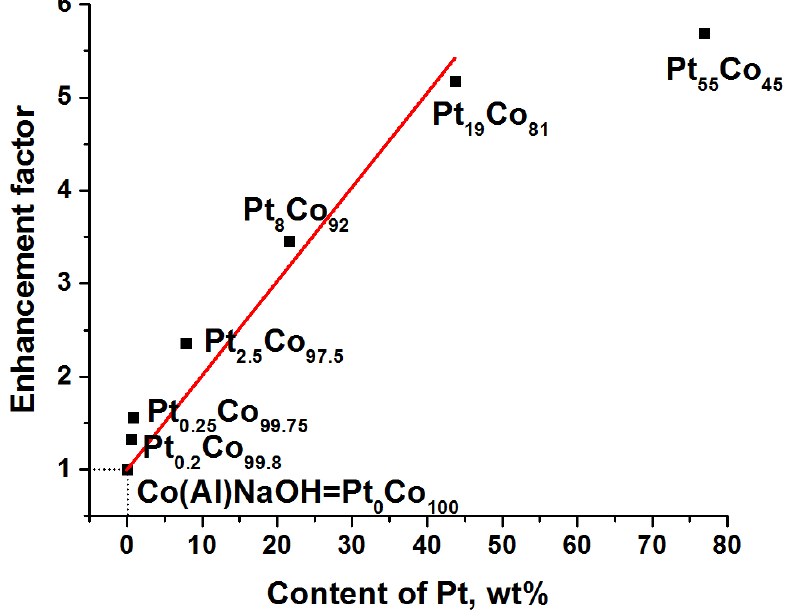
Figure 6. The activity enhancement factor (W 50 PtCo /W 50 Co(Al)NaOH ) of Pt x Co 100 − x catalysts in the NaBH 4 hydrolysis at 40 °C depending on Pt loading (wt%).